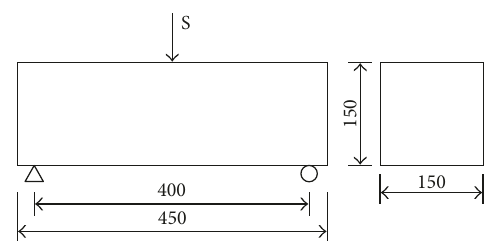
Figure 1: Three-point bending SFPSC beam for fatigue test (unit: